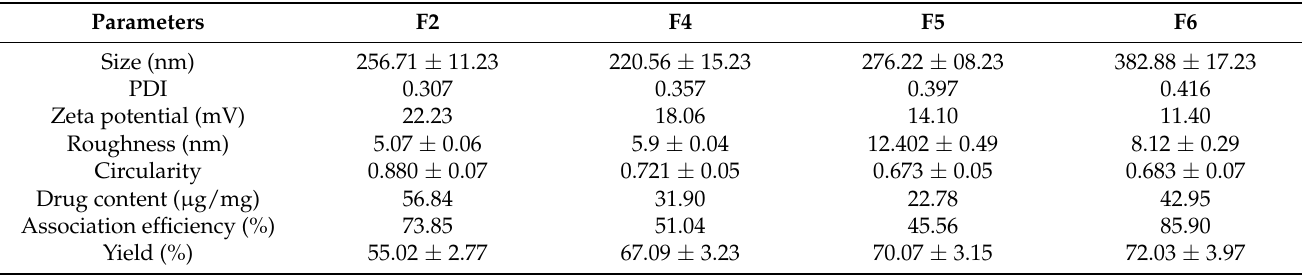
Table 2. Physicochemical characteristics of montelukast-loaded chitosan